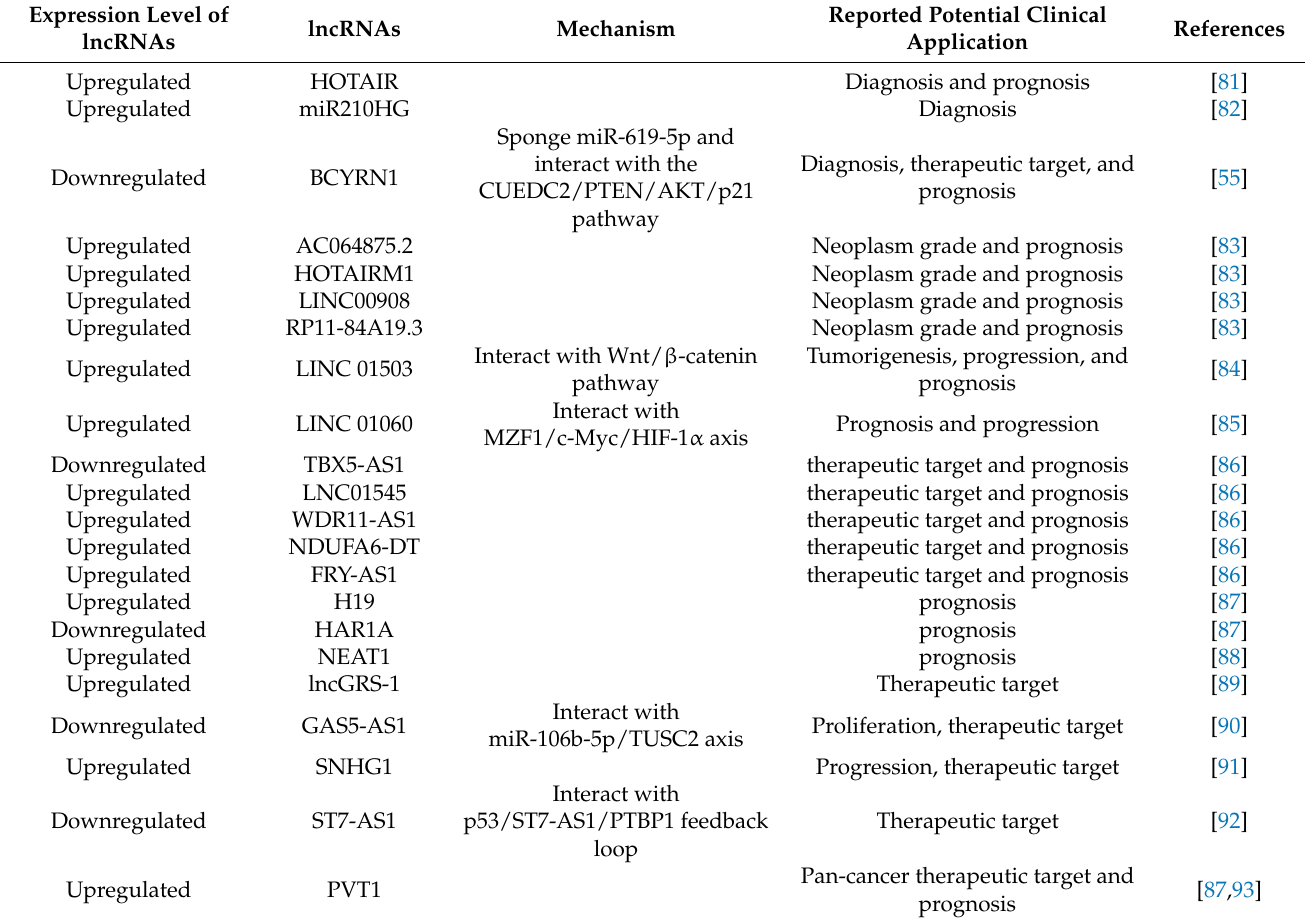
Table 1. lncRNAs with diagnostic, prognosis, and therapeutic potential in